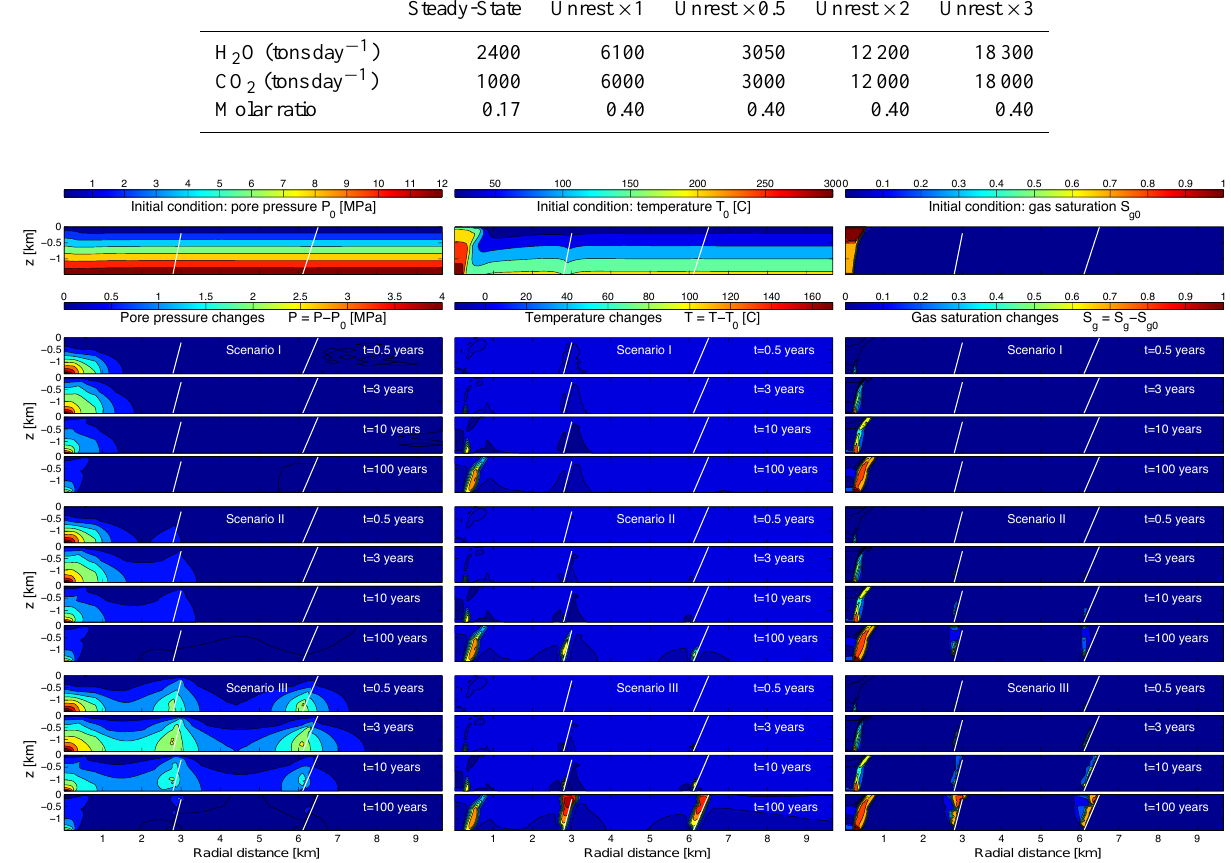
with complete liquid saturation within the fault zones.